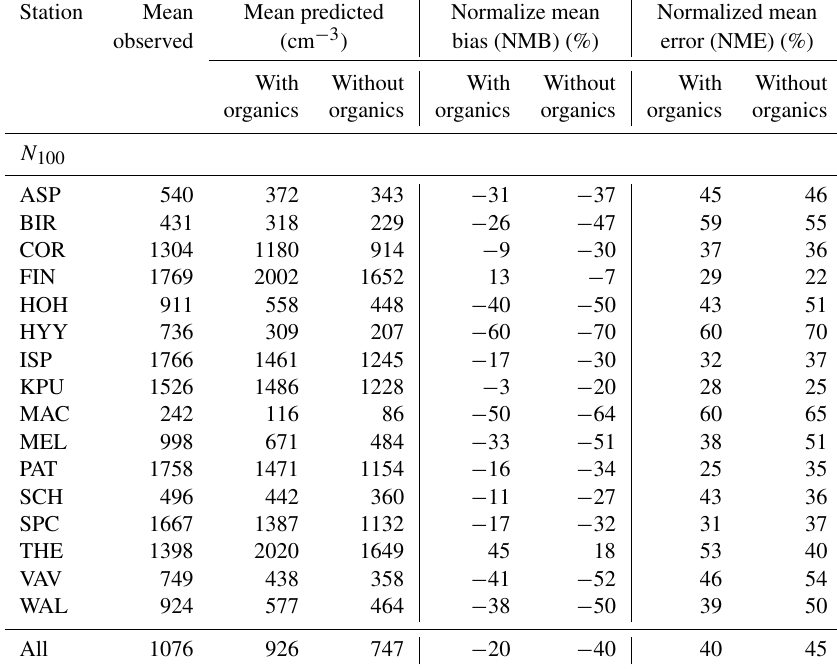
Table 3. Prediction skill metrics of PMCAMx-UF against daily ground measurements of particle number concentration with a diameter above 100nm from 16 stations during 5 June–8 July 2012. Station Mean Mean predicted Normalize mean Normalized mean observed (cm − 3 ) With Without With Without With Without organics organics organics organics organics